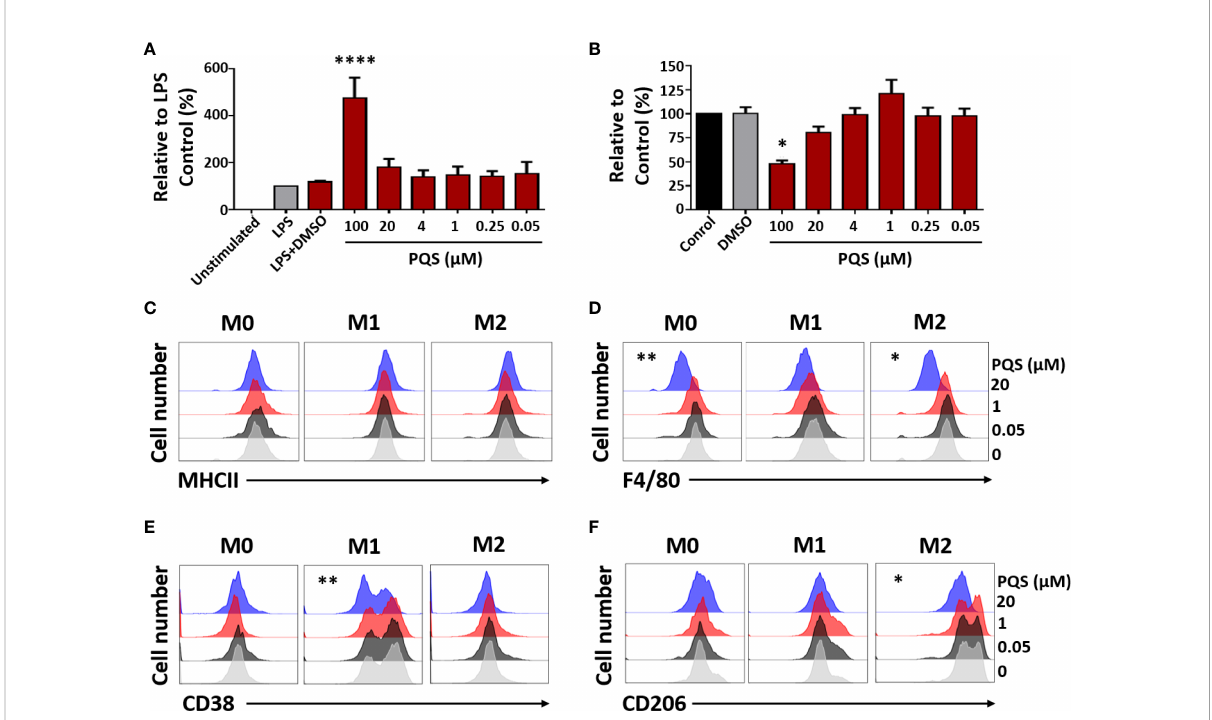
FIGURE 4 PQS modulates human macrophage polarisation. (A) LPS-induced TNF from human monocyte-derived macrophages, in the presence of PQS (0-100 µM); ****P<0.001 relative to LPS plus DMSO (n = 3). (B) Cell viability from (A) measured by the MTT assay; *P<0.05 relative to DMSO. (C-F) M-CSF- differentiated macrophages (M0) were stimulated by M1 (LPS and IFN- g ) or M2 (IL-4 and IL-10) polarizing conditions. The expressions of (C) MHC-II, (D) F4/80, (E) CD38 (M1) and (F) CD206 (M2), assessed using FACS, were modulated by PQS (20 m M) (n = 3). For clarity, the FACS results are shown separately for each PQS concentration. The original display and bar chart analysis are illustrated in Supplementary Figure 1. *P < 0.05, **P<0.01 relative to